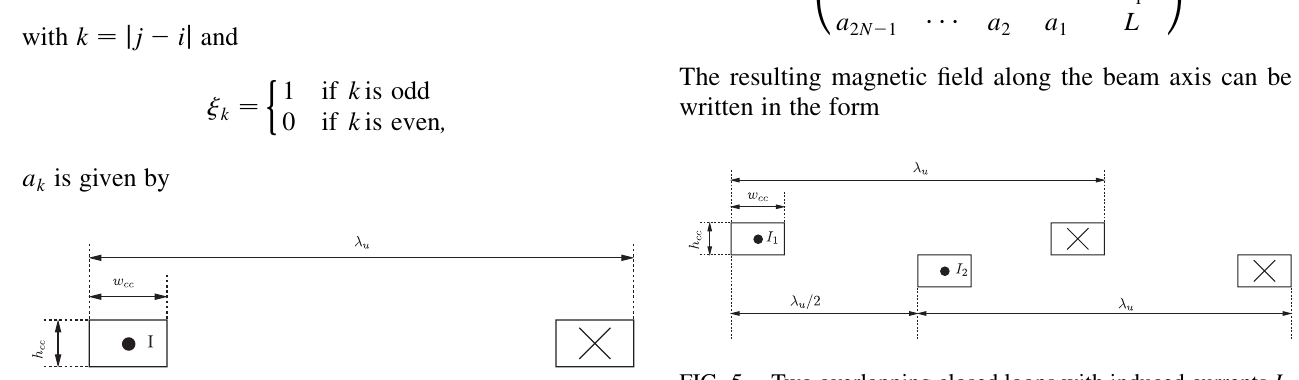
FIG. 5. Two overlapping closed loops with induced currents I 1 and I 2 .